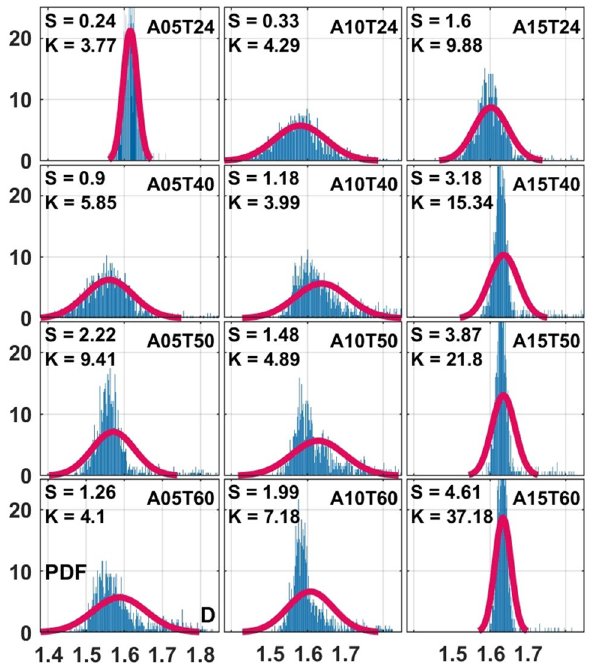
Figure 6. Discrete (blue bars) probability density function (PDF) of the fractal dimension D compared to the Gaussian normal distribution (red line), where S and K respectively denote skewness and kurtosis. Liquid flow rate: q f = 1.8 (kg/h) ( L 04 cases at 4 (lb/h)); bio-oil preheating temperatures: T = 24, 40, 50, 60 ( ◦ C) ( T 24, T 40, T 50 and T 60 cases); Air flow rates: q a = 5, 10, 15 (l/min) ( A 05, A 10 and A 15